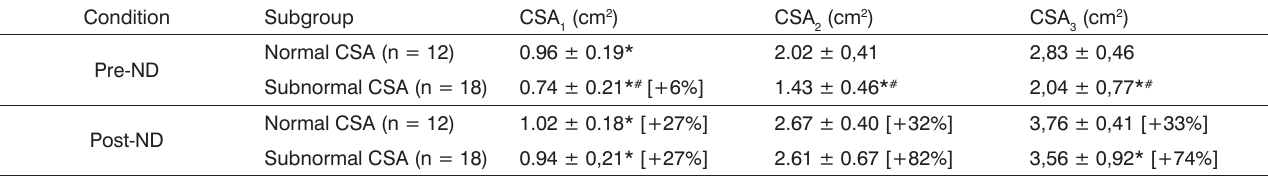
* p < 0.05 statistically significant difference (nasal obstruction patients vs. reference values); # p < 0.05 statistically significant difference (nasal obstruction patients with normal CSA vs. nasal obstruction patients with subnormal